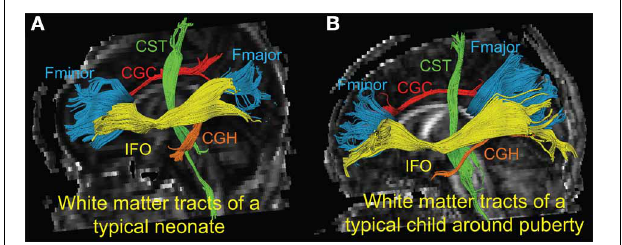
FIGURE 1 | 3-D visualization of the traced WM tracts overlaid on mid-sagittal slice of the FA image of a typical neonate (A) and a typical child around puberty (B). Different colors represent different tracts traced for both subjects. CGC_L/R, CGH_L/R, CST_L/R, FMajor/FMinor and IFO_L/R are painted by red, orange, green, blue, and yellow color, respectively.